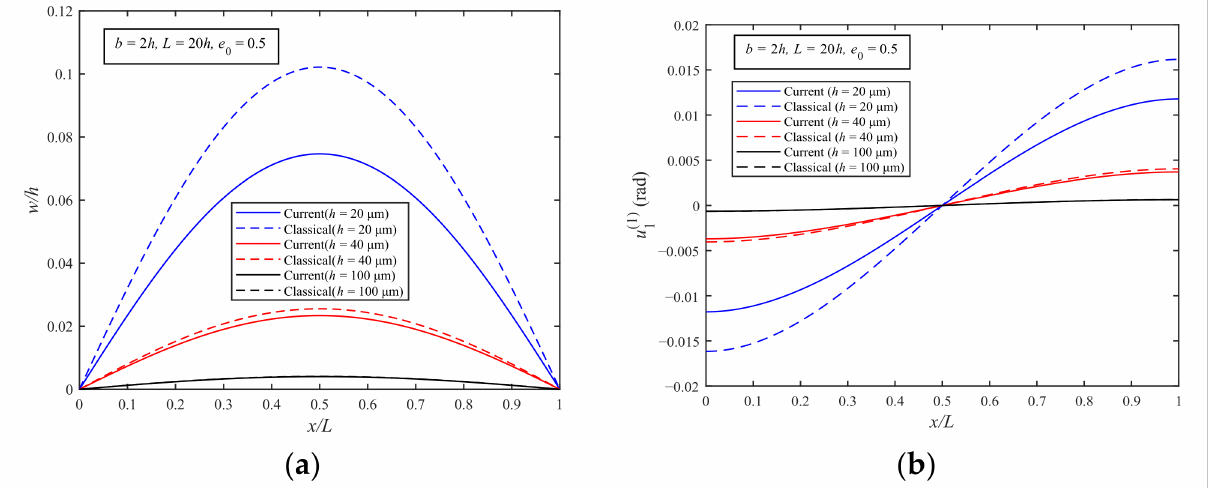
Figure 4. Deflection ( a ) and rotation ( b ) of the MEEFGP simply supported microbeam (porosity coefficient = 0.5).